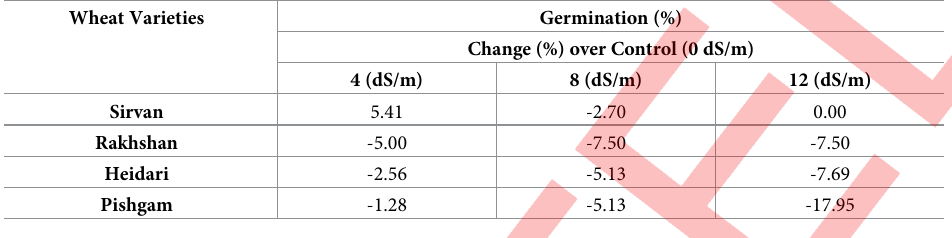
Table 1. Percentage change in germination of different wheat varieties as influenced by variable salinity levels.